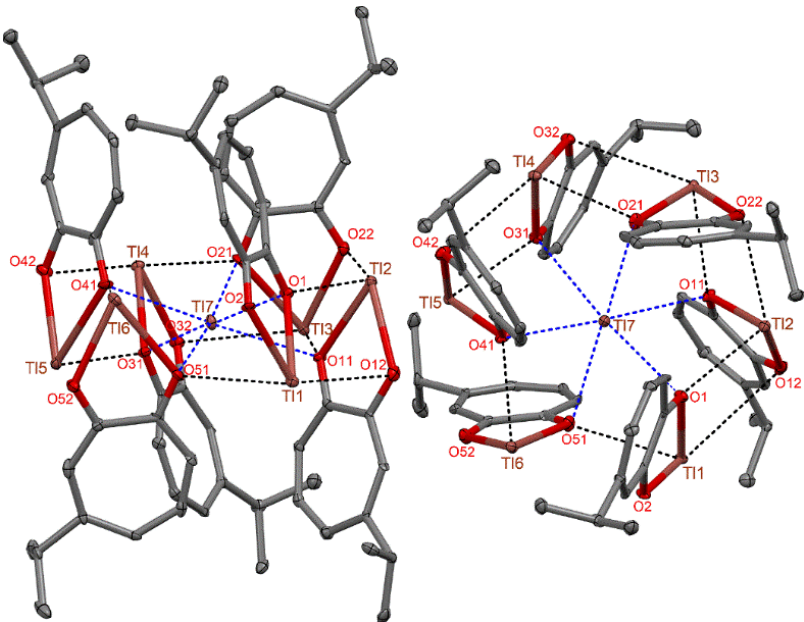
Figure 8. Asymmetric unit of 4 in two different views showing intermolecular contacts between Tl(hino) molecules (black dotted lines) and the shortest distances for the free Tl + ion (blue dotted lines). Atoms are shown as 50% ellipsoids. Hydrogen atoms and the triflate ion were omitted for clarity.